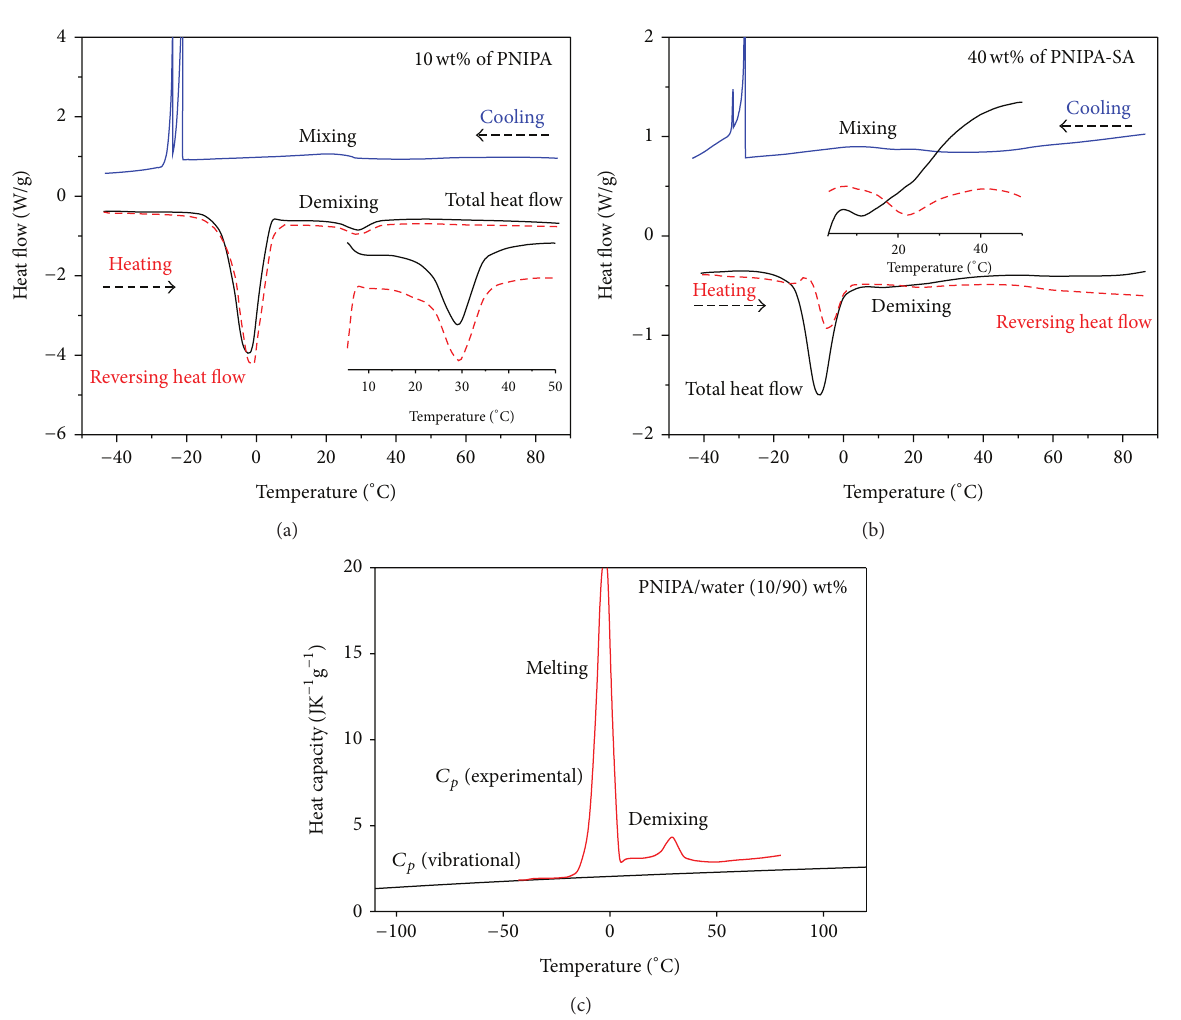
Figure 4: ((a), (b)) TM-DSC thermogram of gel/water system in equilibrium swelling degree: (a) PNIPA/water (10%/90%) and (b) PNIPA- SA (40%/60%). Onset values of LCST were taken from the TM-DSC plots (reversing heat flow) upon first and second heating at 5 ∘ C/min. Cooling was performed with 10K/min by standard DSC. Endotherms around 0 ∘ C on heating and exotherms around − 30 ∘ C on cooling are related to melting and crystallization of water, respectively. (c) Experimental, reversing heat capacity of the 10%/90% PNIPA/water and their vibrational baseline, 𝐶 𝑝 (vibrational) [44,